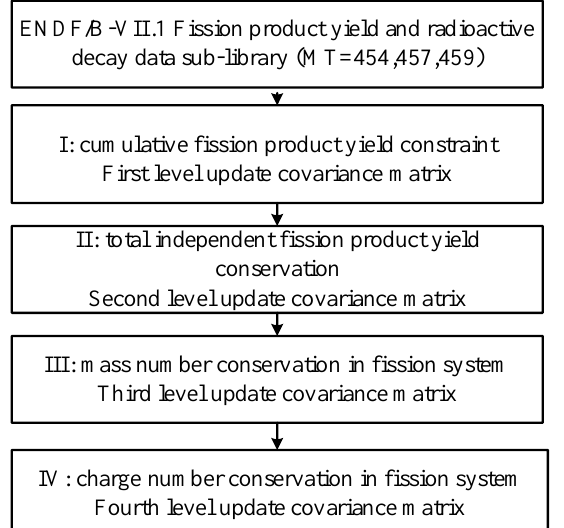
Figure 1. For a detailed derivation of this estimation, please refer to Wang et at. [9], which focuses on estimating the covariance matrix of independent fission product yield from thermal neutron induced 235 U fission based on the Bayesian updating method. Under the Bayesian method, multivariate normal distributions are assigned as fission product yields' prior distribution and its mean vector as well as covariance matrix (which is a diagonal matrix) is taken from the ENDF/B-VII.1 fission product yield sub-library. There are four constraints regarding to the independent fission product yield that are used to construct the likelihood function. The prior probability distribution of fission product yield is updated with the weights from likelihood function, and the posterior probability distribution is ob- tained. Compared with fission product yield covariance matrix under the prior probability distribution, the covariance matrix under the posterior probability distribution pertains to the above physical constraints. The mentioned four physical constraints considered in this work are: cumulative and independent fission product yield consistency; binary fission constraint (total independent fission product yield conservation); fission system mass number conservation constraint and fission system charge number conservation constraint.